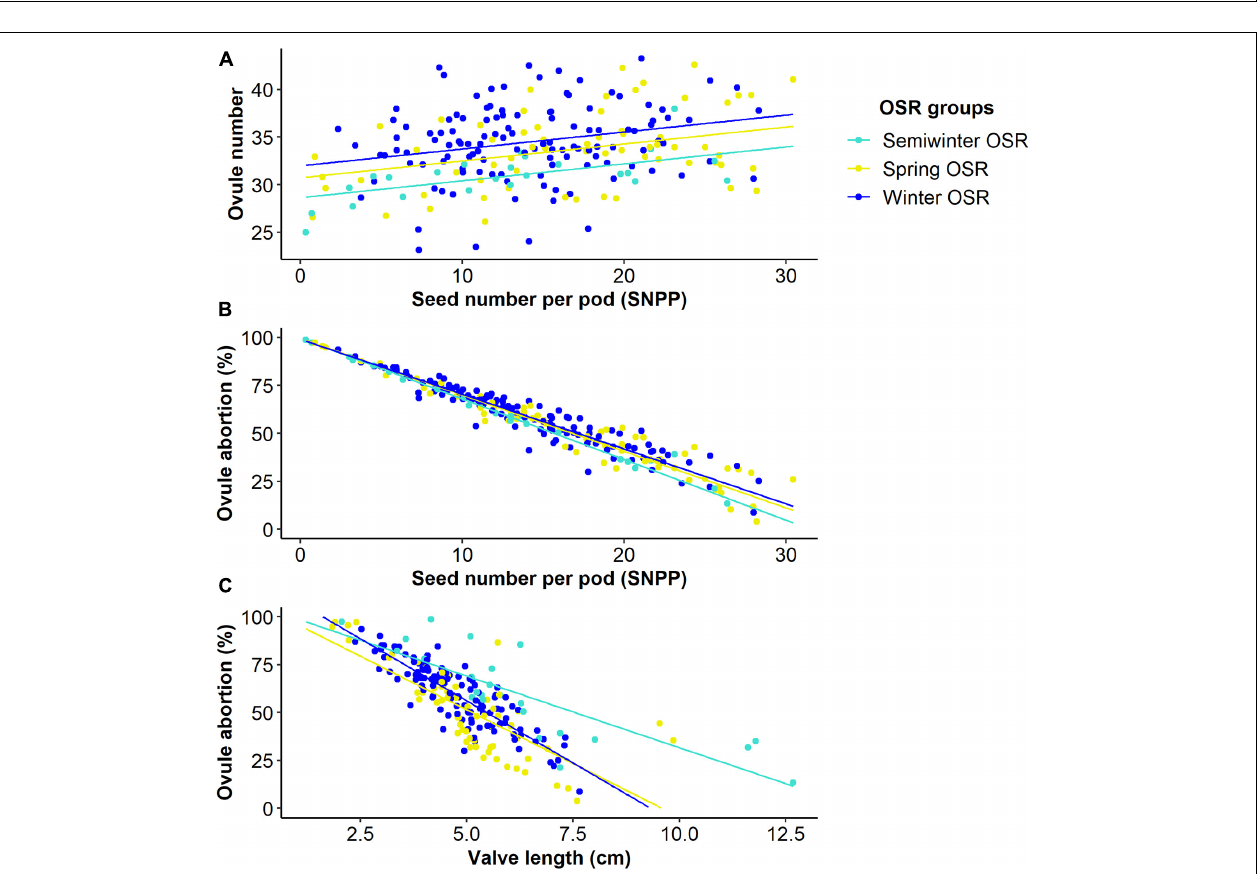
FIGURE 4 | Relationships between seed number per pod (SNPP) and valve length and two microtraits in Winter OSR, Spring OSR, and Semiwinter OSR ( n = 3). (A) Linear regression for ovule number vs. SNPP, (B) generalised linear model for ovule abortion vs. SNPP, (C) linear regression for ovule abortion vs. valve